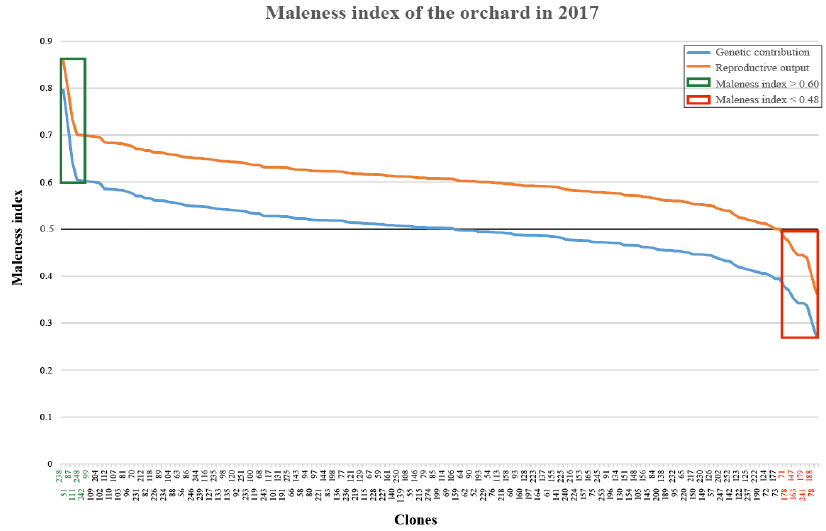
Figure 1. The 2017 clone maleness index.